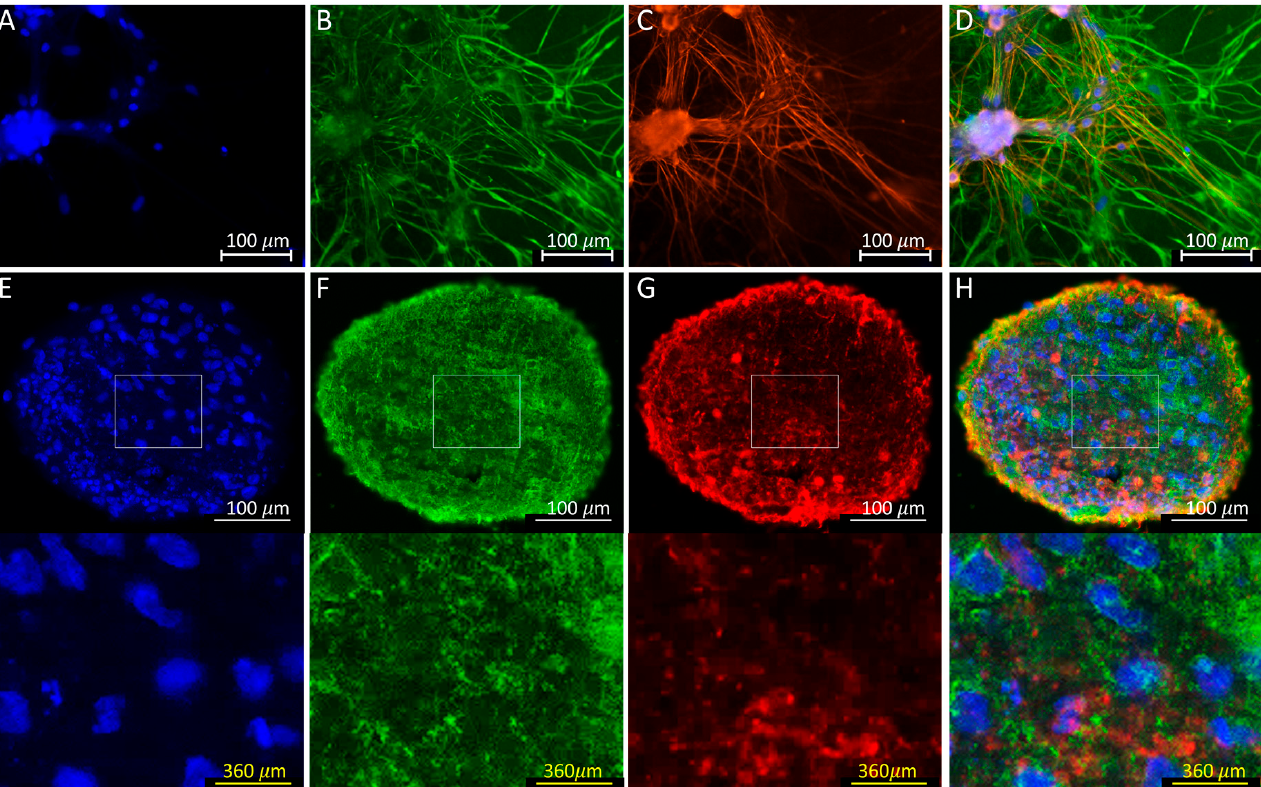
Figure 5. Immunofluorescence microscopy of hiPSC-derived neurons cultured with human primary astrocytes. Images show nuclei visualized using Hoechst 33342 ( A , E ) and localization of MAP2 ( B , F ) and GFAP ( C , G ) in the representative 2D ( A – D ) and spheroid ( E – H ) cultures. In D and H, the corresponding images ( A – C ) and ( E – G ) were merged, respectively. Rectangles shown in ( E , F , H ) are magnified at the bottom.